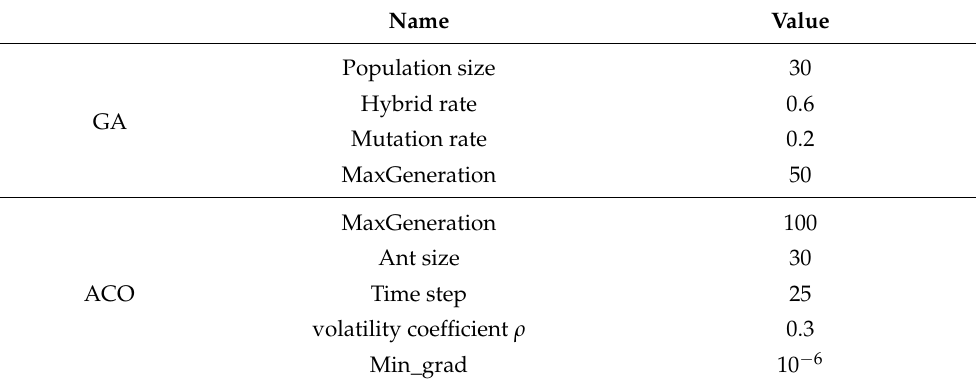
Table 3. Optimization algorithm network parameters